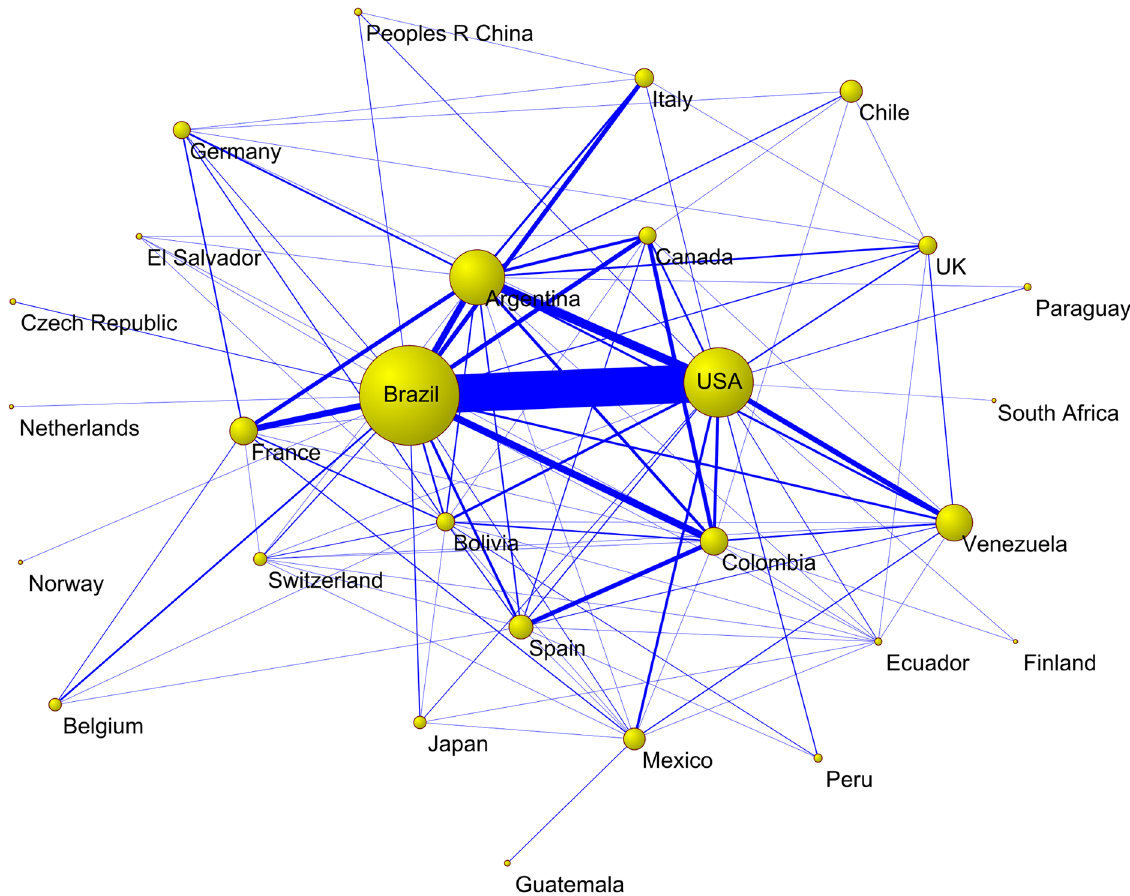
Fig 2. Collaboration network between countries on Chagas cardiomyopathy, records indexed in